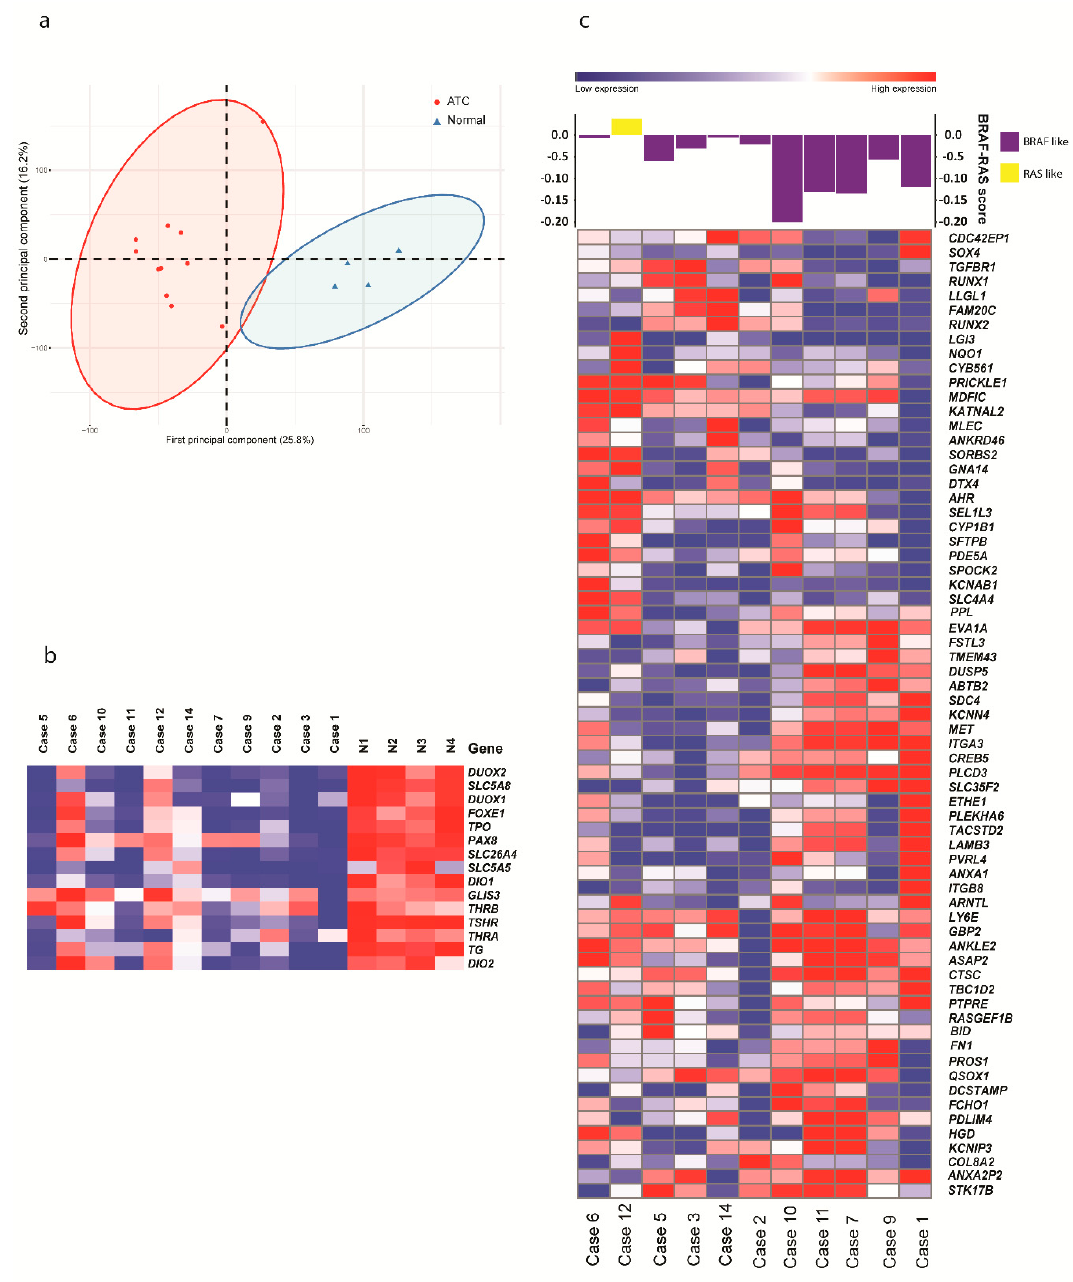
Figure 1. Expression analysis of anaplastic thyroid cancer (ATC). ( a ) Unsupervised clustering by principal component analysis of expression data from 11 ATC cases and tissue from four normal thyroids, showing clear clusters. ( b ) Heatmap displaying relative expression of 15 genes related to thyroid differentiation score in 11 ATC and tissue from four normal thyroids (N1-N4). ( c ) Heatmap displaying expression of 67 genes in BRAF-RAS score signatures in ATC. Based on their expression, cases were classified as BRAF- like (purple) or NRAS-like (yellow) in the top panel.